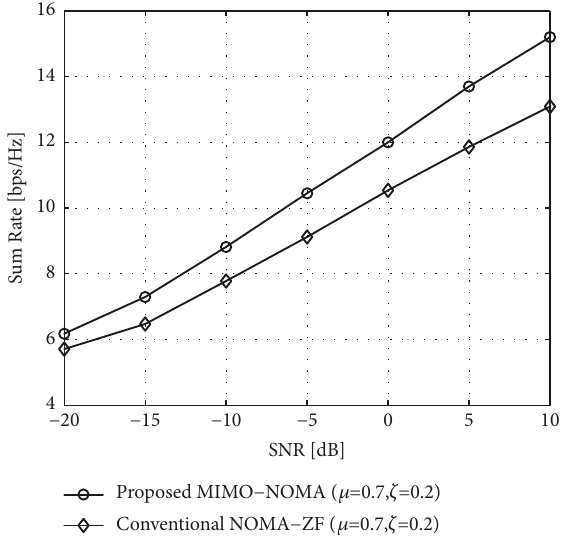
Figure 5: Sum rate performances of the proposed schemes with different quantization bits ( 𝜇 =0.7; 𝜁 =0.2) and the random beam- forming scheme with one-bit feedback ( Δ = 0.1) against